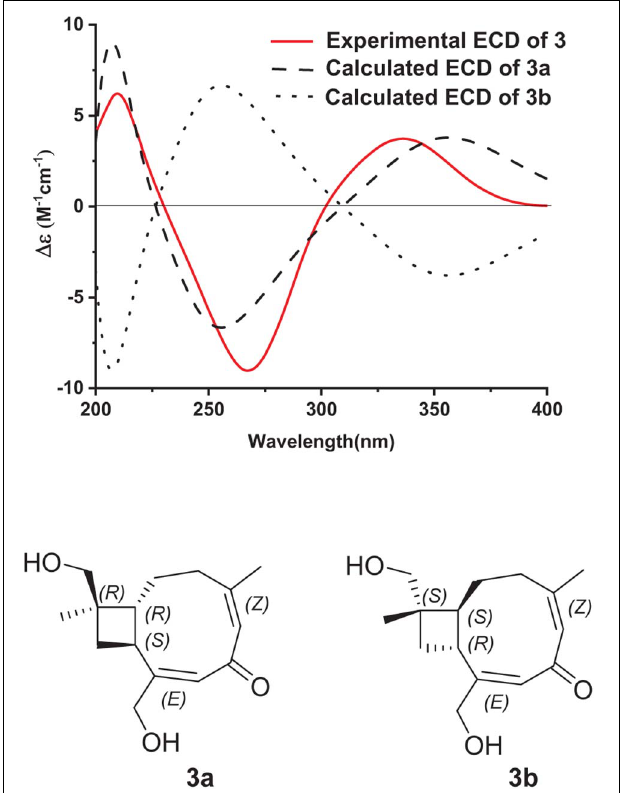
spectrum, the cross peak between H-2 and H-14 assigned the